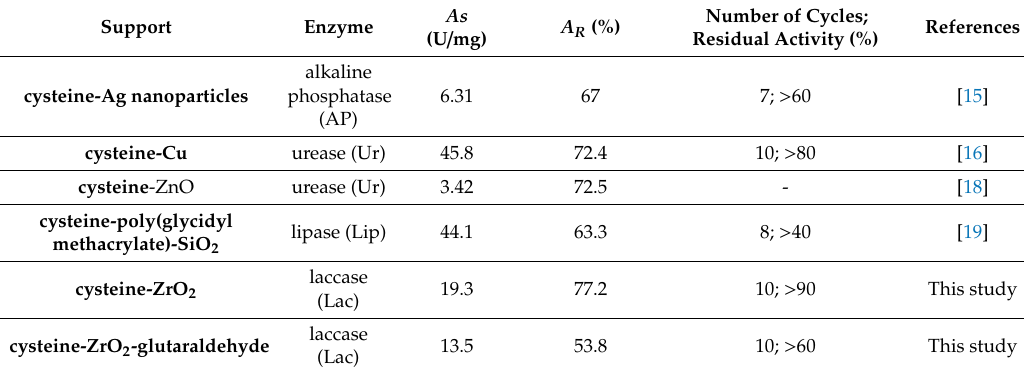
Figure 5. Influence of ( a ) pH, ( b ) temperature, ( c ) storage stability and ( d ) reusability on relative activity of free and immobilized laccase. Summary of catalytic properties obtained for di ff erent enzymes immobilized on cysteine-functionalized